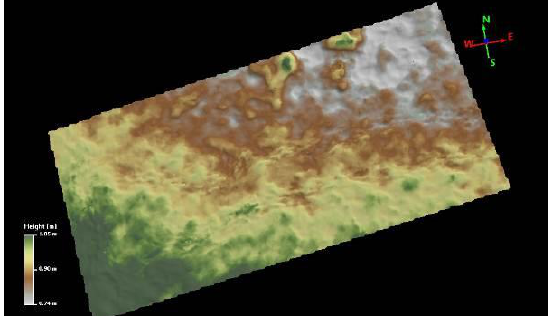
Figure 10. Difference between fixed-wing and multi-rotor gully